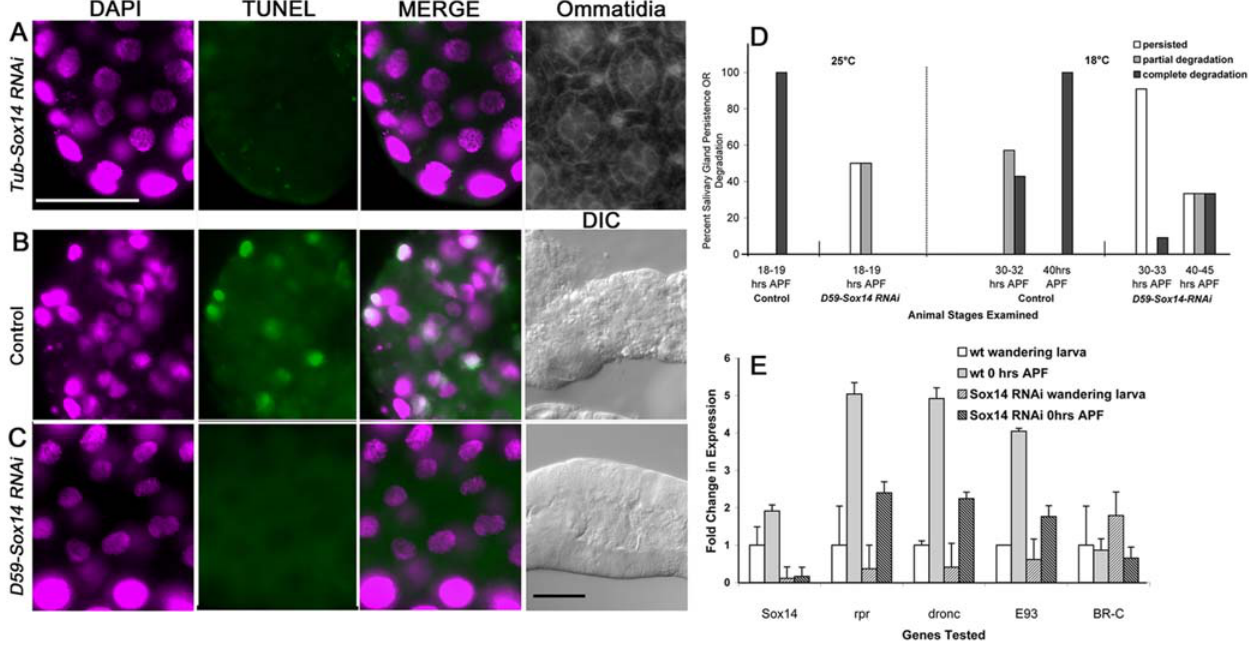
Figure 7. Sox14-RNAi results in a delay or inhibition of salivary gland cell death. A. In Tub-Sox14-RNAi pupae, intact salivary glands persisted past the stage of wild-type salivary gland cell death (15–18 hrs APF at 25 C). Shown is a segment of an intact salivary gland from a Tub-Sox-14-RNAi pupa that is devoid of TUNEL positive nuclear staining (DAPI=magenta; TUNEL=green). Phalloidin staining of retinas dissected from the same animal in (B) was used as an independent morphological marker to help determine developmental age. The ommatidial arrangement shown (far right) indicates that the animal developed to at least 30 hrs APF (25 C). B. In control pupae ( D59-GAL4/D59-GAL4 ; MKRS/TM6B ), extensive nuclear TUNEL staining (DAPI=magenta; TUNEL=green) and degradation (DIC) was evident at stages equivalent to 16–17 hrs APF at 25 C (or 30–32 hrs APF at 18 C). C. In D59-Sox14-RNAi pupae, salivary gland cell death was delayed. Shown is a salivary gland dissected at the same stage as the animal in (B). There is no evidence of TUNEL positive (green) nuclei (DAPI=magenta) and no indications of degradation (DIC). Scale bars for fluorescent and